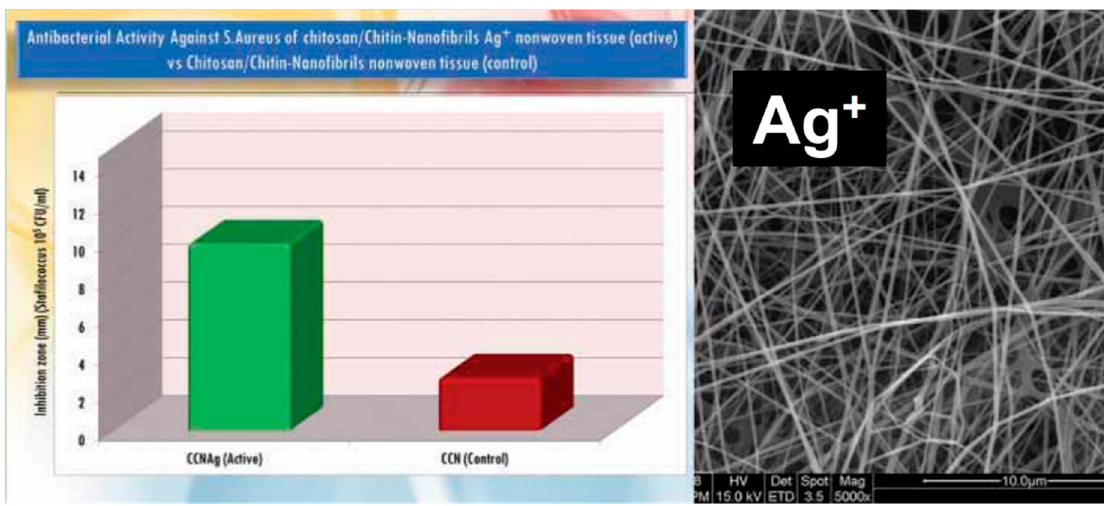
Figure 17. Skin barrier repairing activity of chitin nanofibrils [56].